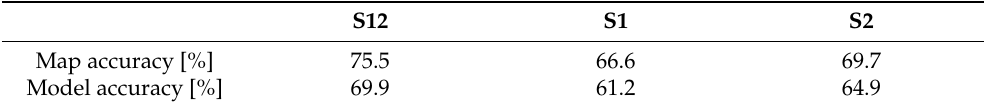
Table 2. Overall map (area adjusted) and model accuracies of the crop type classifications for the Germany-wide RF model using Sentinel-1 and Sentinel-2 features combined as input feature sets (“S12”) and using the two sensors independently (“S1” and “S2”, respectively). S12 S1 Map accuracy